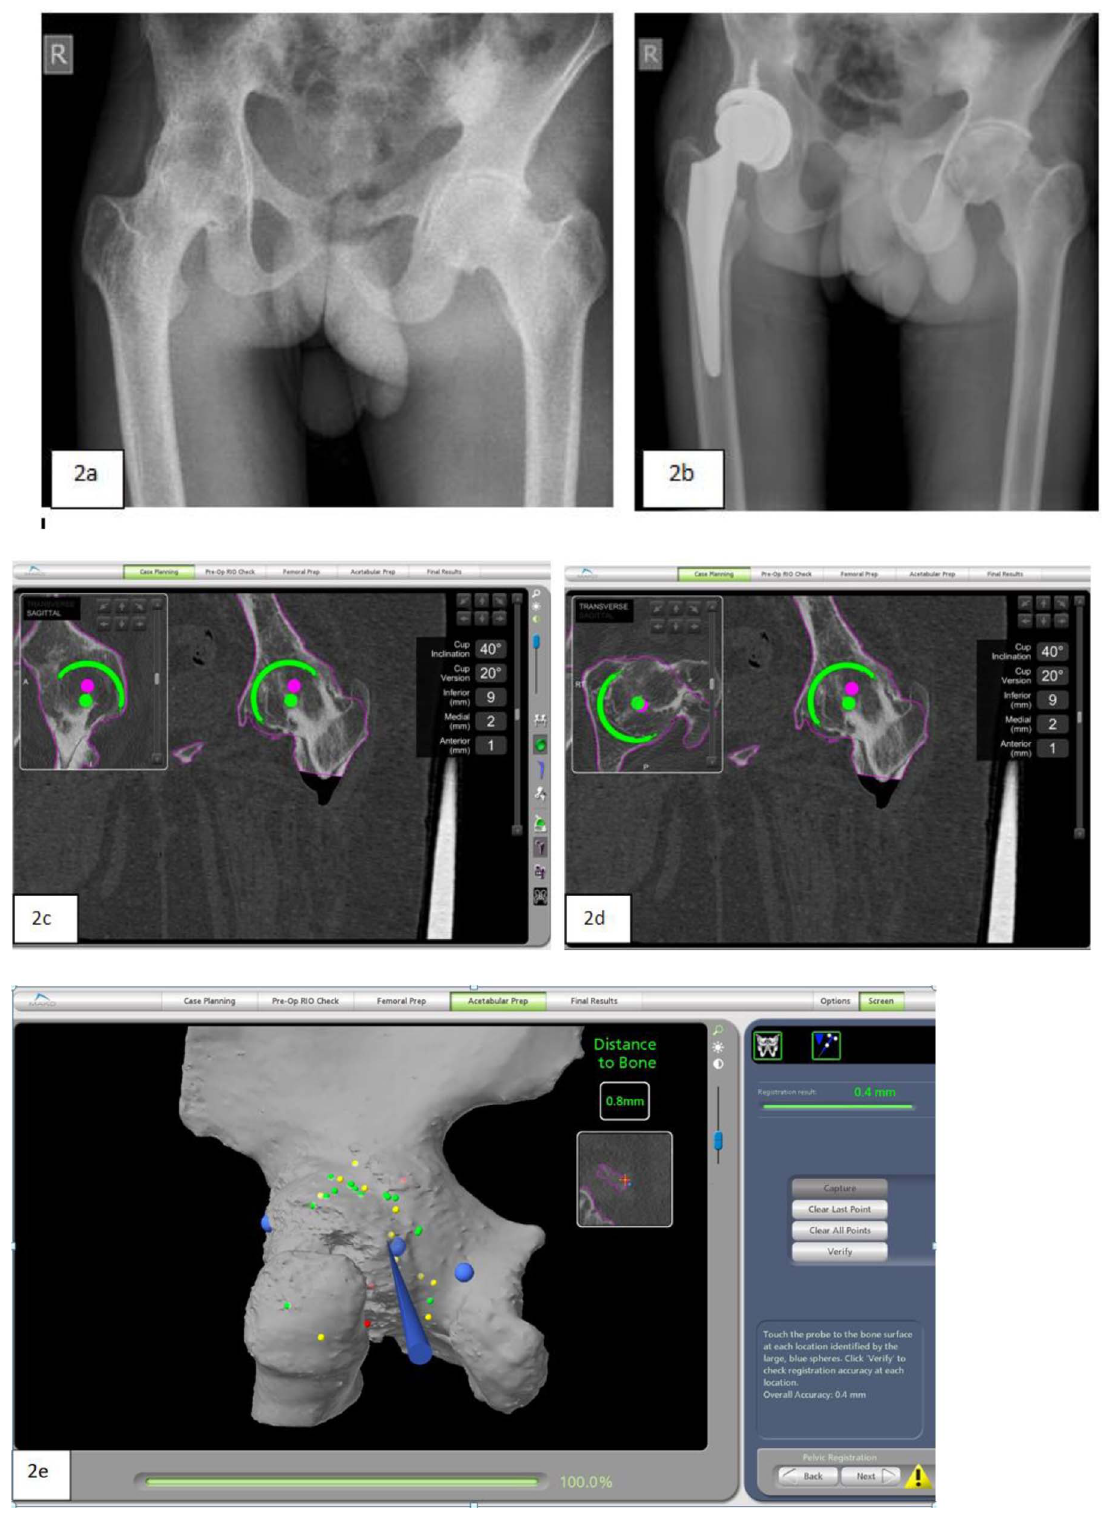
Figure 2. Case 5. (a) Preoperative antero-posterior (AP) view (bony ankylosis of right hip). (b) Six months antero-posterior (AP) view of the pelvis. ( c) and (d) Preoperative planning for case 5 in transverse and sagittal plane. (e) Veri fi cation of pelvic rotation by localizing the anterior superior iliac spine with the hip